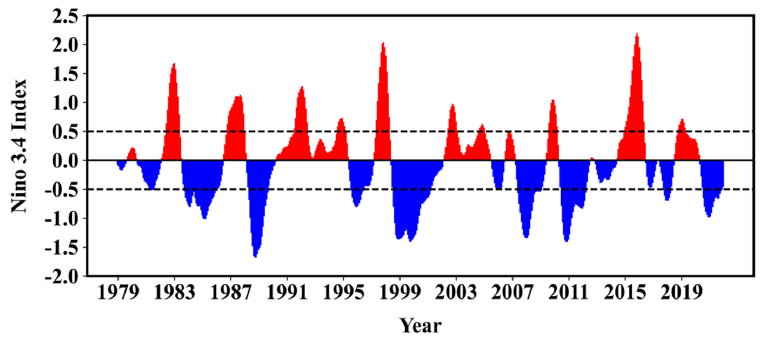
Figure 1. Time series of the Nino 3.4 index in 1979 − 2021.